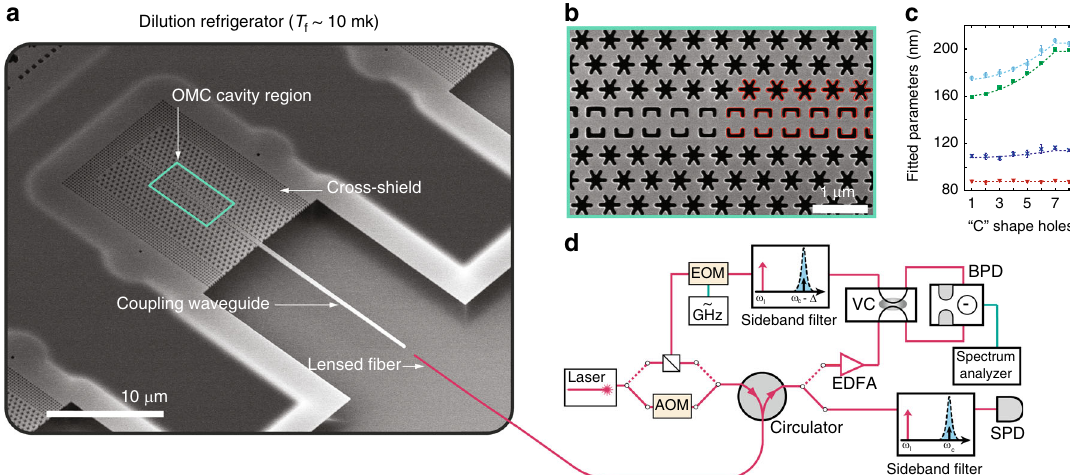
Fig. 2 Device fabrication and measurement set-up. a SEM image of a full quasi-2D snow fl ake OMC device fabricated on SOI. This device is an “ 8-shield device ” in which an additional eight periods of cross-structure phononic bandgap shielding is applied at the periphery (see Supplementary Note 4). A lensed optical fi ber is used to couple light into a tapered on-chip waveguide, which is butt-coupling to the quasi-2D snow fl ake OMC cavity. b SEM image of the center of the cavity region. Fitting to the geometries for “ C ” -shaped holes and snow fl ake holes in the cavity region are shown as red solid lines. c Measured “ C ” parameters fi t from SEM images of a fabricated cavity (dots) along with their design values (dashed curves). Shown over one half of the cavity ( fi rst 8 “ C ” shapes on the right side of the cavity) are the parameters (from top to bottom): h o (cyan circles), w o /2 (green squares), h i (blue crosses), and w i /2 (red triangles). Error bars in geometrical parameters correspond to standard deviation of ten sets of measured SEM images. d Experimental set- up for characterization of the quasi-2D snow fl ake OMC cavity. Multiple optical switches are used to switch between continuous wave and pulsed optical excitation and between heterodyne spectroscopy and single photon detection. AOM acousto-optic modulator, EOM electro-optic modulator, EDFA erbium-doped fi ber ampli fi er, VC variable coupler, BDP balanced photodetector, SPD single photon detector. A more detailed schematic and description of the measurement set-up is provided in Supplementary Note